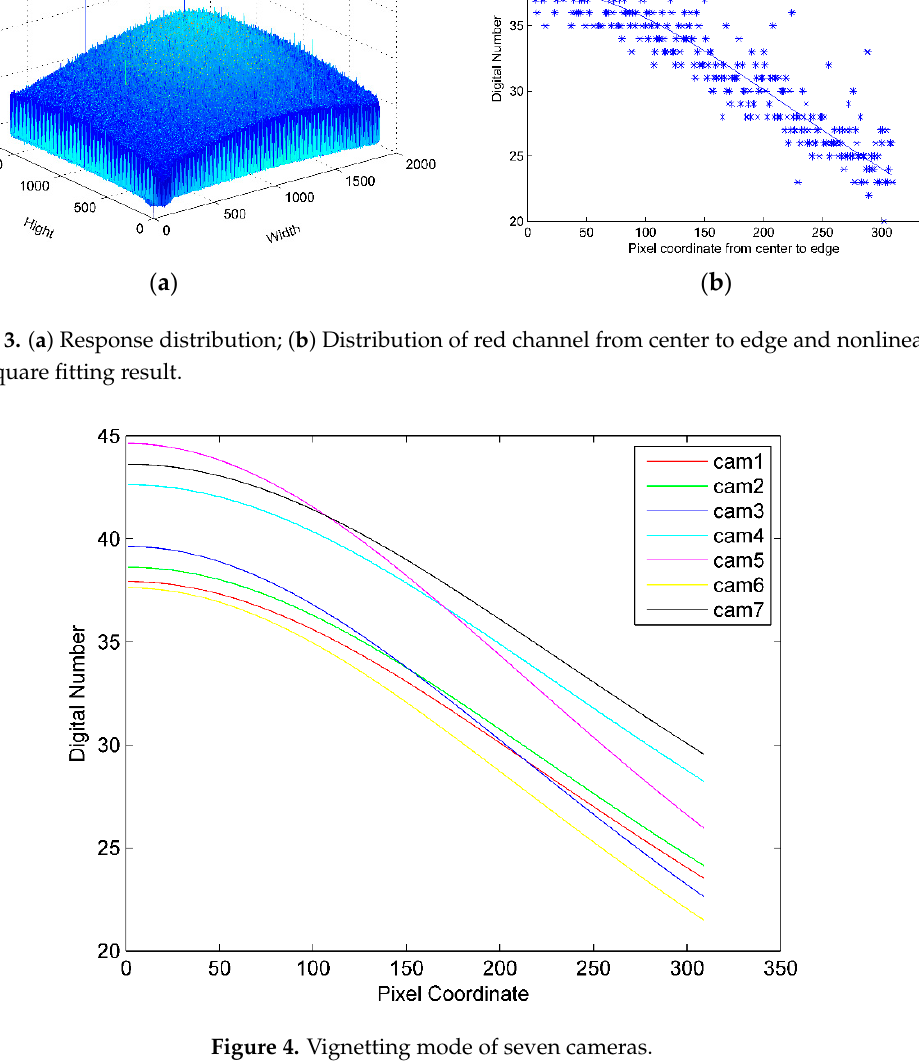
Figure 4. Vignetting mode of seven cameras.